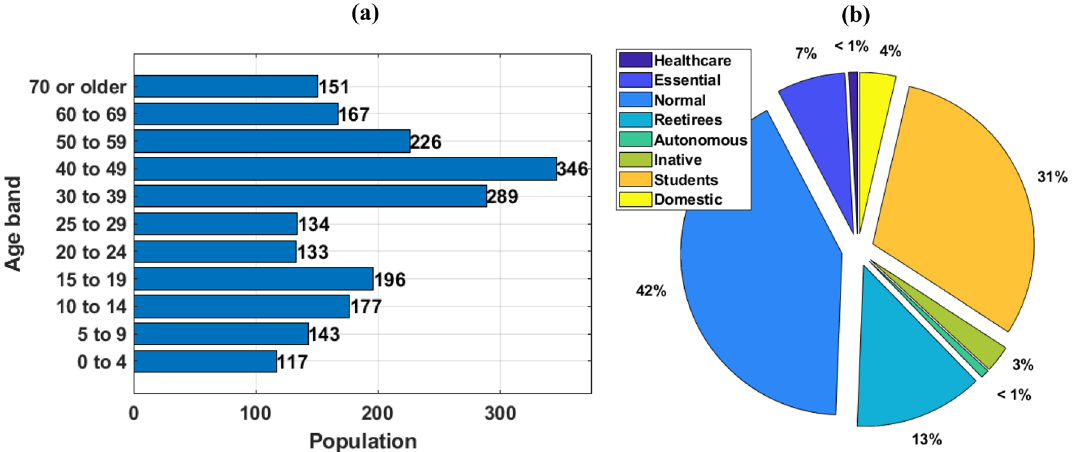
Figure 7. Aged ( a ) and professional activity ( b ) distributions of the Passa Vinte city (MG) city 5